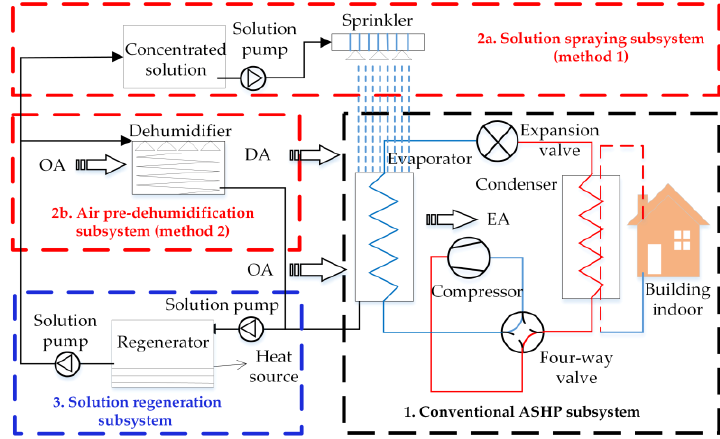
Figure 13. Schematic diagram of FFASHP heating systems based on liquid desiccant.